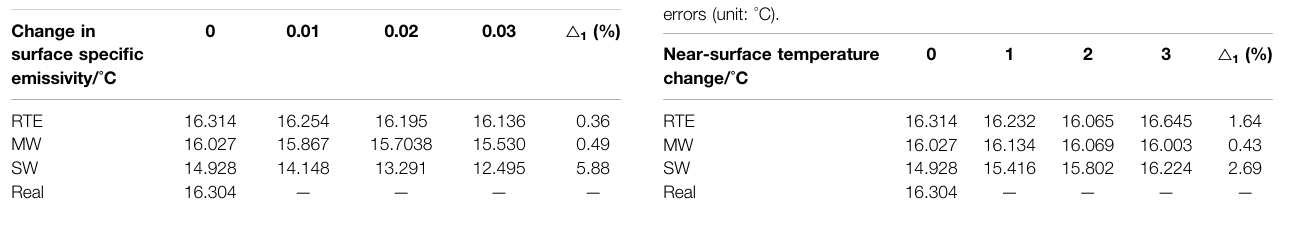
TABLE 6 | Surface temperature change due to surface speci fi c emissivity error (unit: ° C).